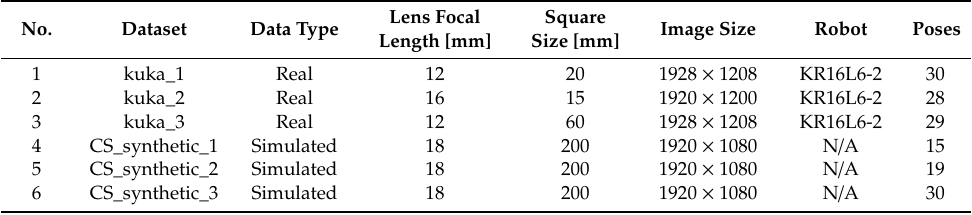
Table 1. Description of the dataset acquired and generated for